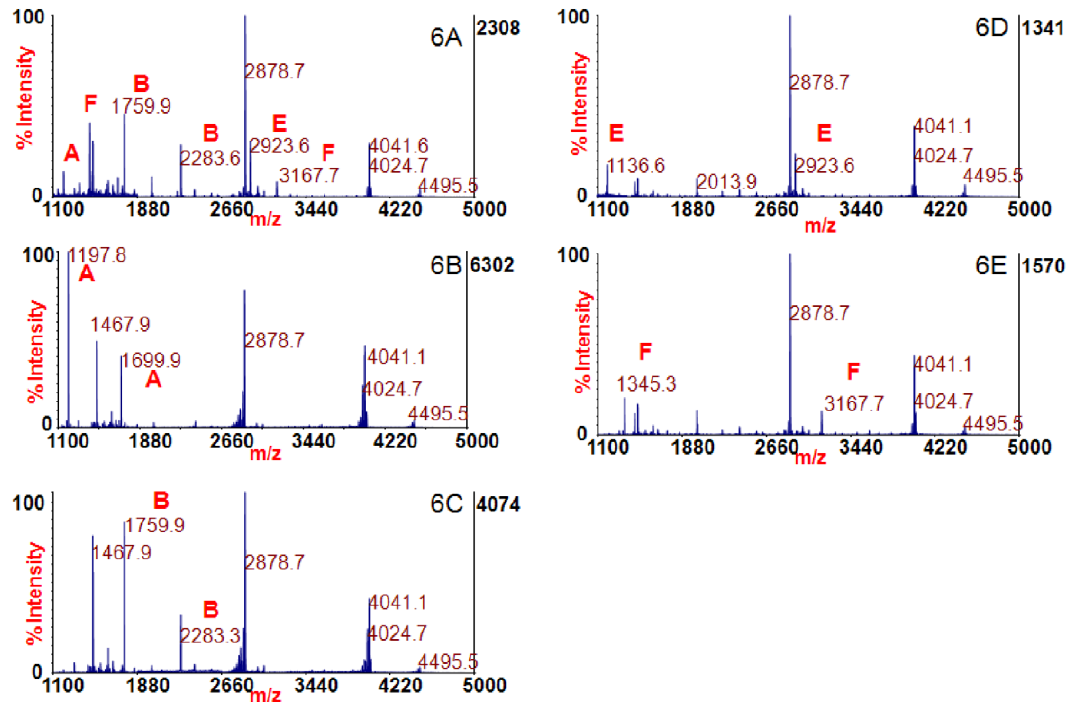
Figure 6. Mass spectrum of the Endopep-MS reaction of the simultaneous extraction of BoNT/A, /B, /E, and /F with monoclonal antibody 4E17.1 (6A) or the single extraction of BoNT/A (6B), /B(6C), /E (6D), or /F (6E) with serotype-specific antibodies. Cleavage products indicating those four BoNTs are marked.